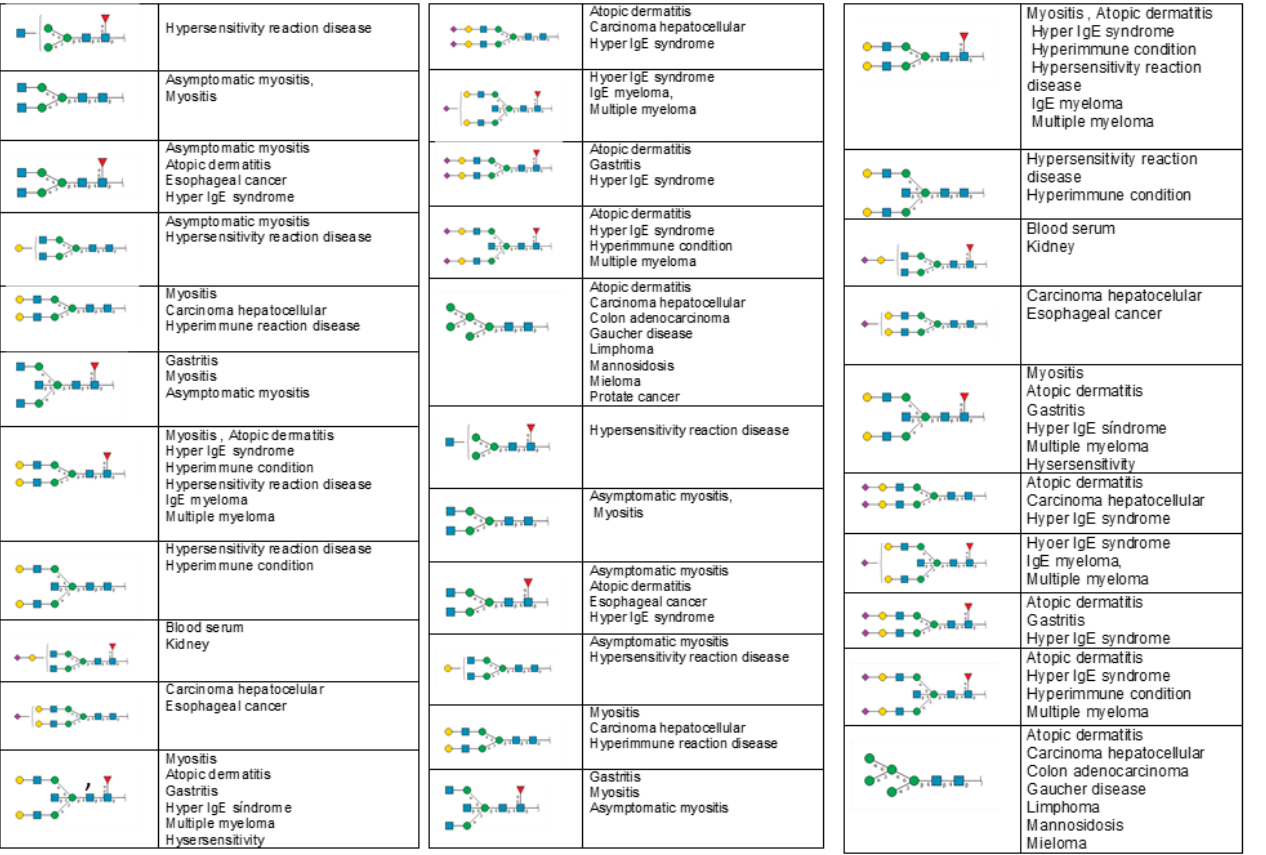
Figure 3. Altered glycans in the immunoglobulins of SLE patients and other diseases where they have been reported. Data were obtained from the GlyConnect Octopus database showing associations between proteins, diseases, and glycans.